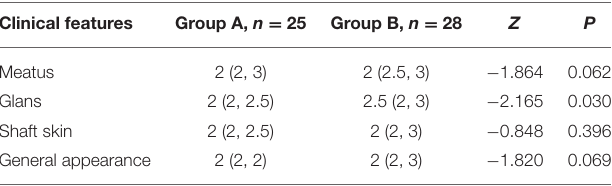
TABLE 4 | Comparison of two groups in PPPS by parents 3 months after operation. Clinical features